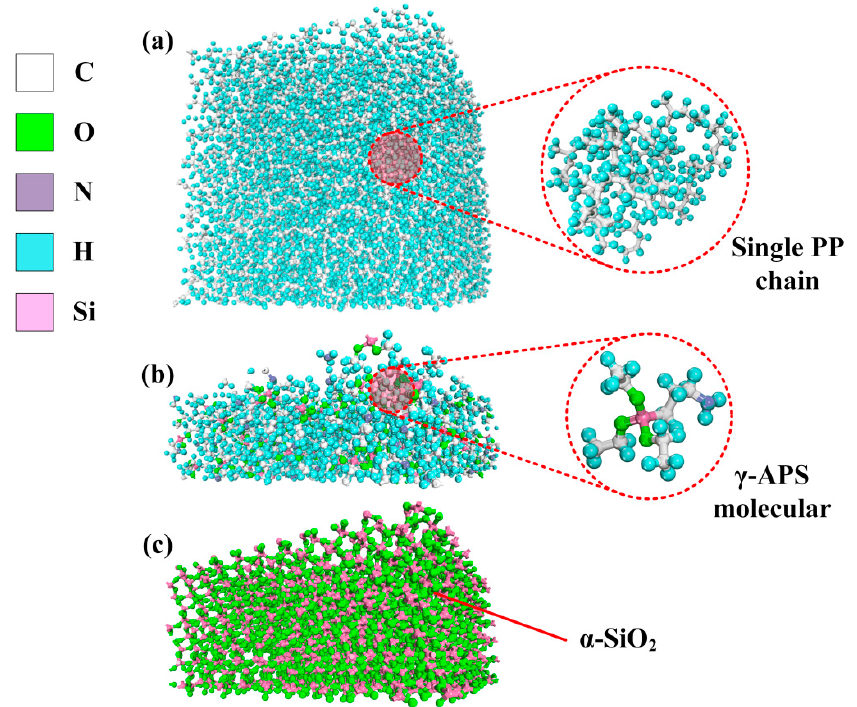
Figure 2. Atomistic models of ( a ) PP matrix, ( b ) silane sizing, and ( c ) glass fiber.